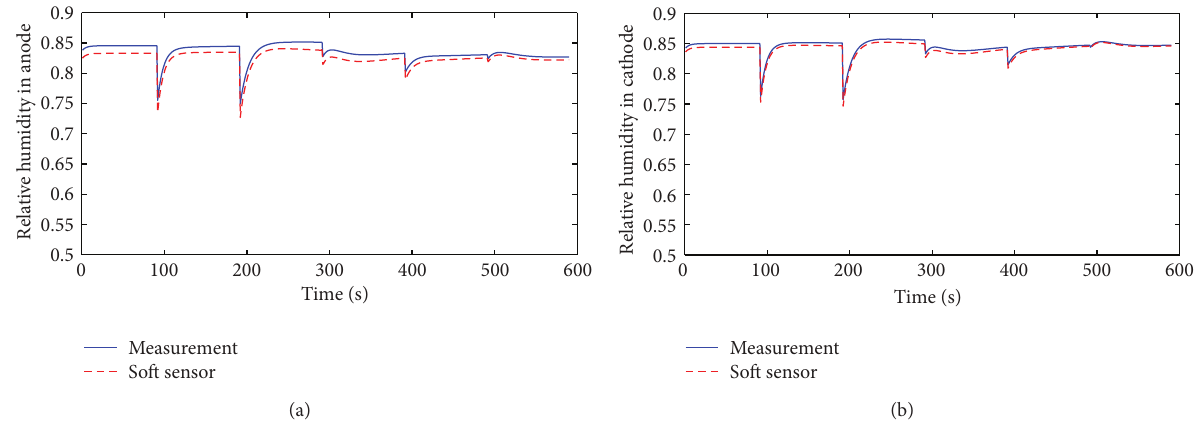
Figure 13: Comparison of measured and soft sensor’s relative humidity in the speed-up condition when relative humidity of cathode is set as 0.85. (a) Anode; (b)